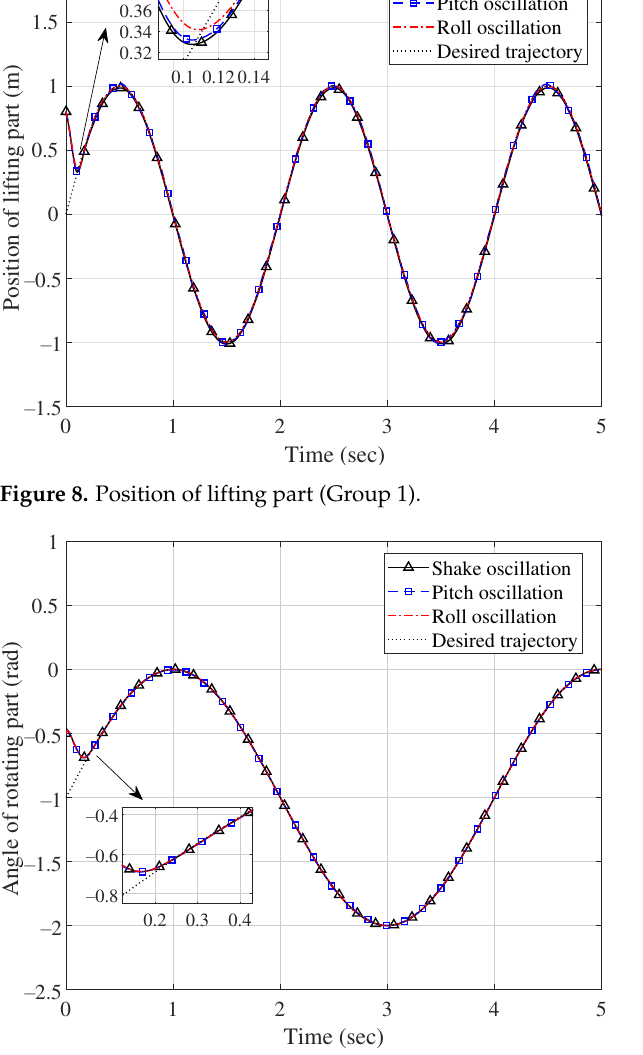
Figure 9. Angle of rotating part (Group 1). Here, the black solid, blue dashed, and red dash-dotted line correspond to the case of shake, pitch, and roll oscillation, respectively; the black dotted line indicates the given desired trajectory. Figures 8 and 9 present the position and angle response of the lifting part and rotating part, respectively. Figures 10 and 11 demonstrate the velocity of the lifting part and the angular velocity response of the lifting part and rotating part, respectively. We can see from Figures 8 and 9 that the proposed control effectively suppresses the influence of base oscillations and compliant-actuator-caused flexible vibration, and realizes rapid robust trajectory of the ammunition transfer manipulator. For three cases, the steady-state times of the control are all less than 0.2. Moreover, from Figure 10, we can see that the shake base oscillation has the most significant influence on the velocity response of the lifting part, and the curves exhibit obvious chattering characteristics. Similarly, we can also see from Figure 10 that the pitch oscillation has the most significant influence on the angular velocity response, and the curves also show chattering